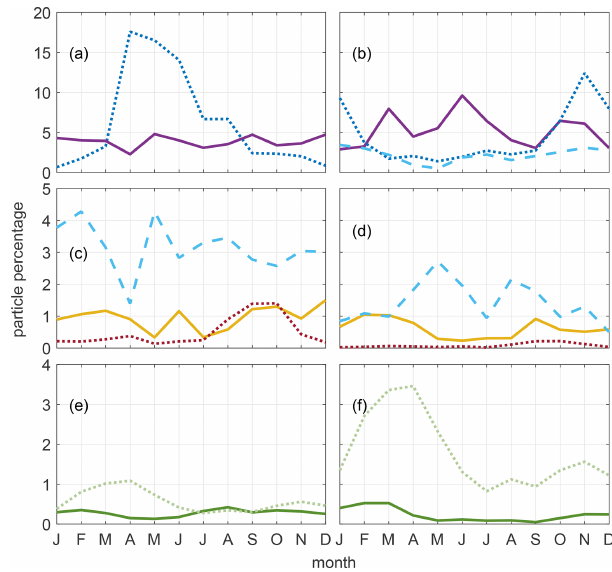
Figure 10. Mean seasonal cycle of particle percentage travelling be- tween distinct sections along their main pathways and their release points in the western basin (a, c, e) and the eastern basin (b, d, f) , respectively. Sections are along 21 ◦ N shown as a dotted dark blue line and 17 ◦ N as a solid purple line (a, b) , 64.3 ◦ E as a dashed light blue line (b, c, d) , 60 ◦ E as a solid yellow line, 51 ◦ E as a dotted red line (c, d) , and 10 ◦ N as a dotted light green line (east) and a solid green line (west) (e, d) . For line colour and type, please see Fig.